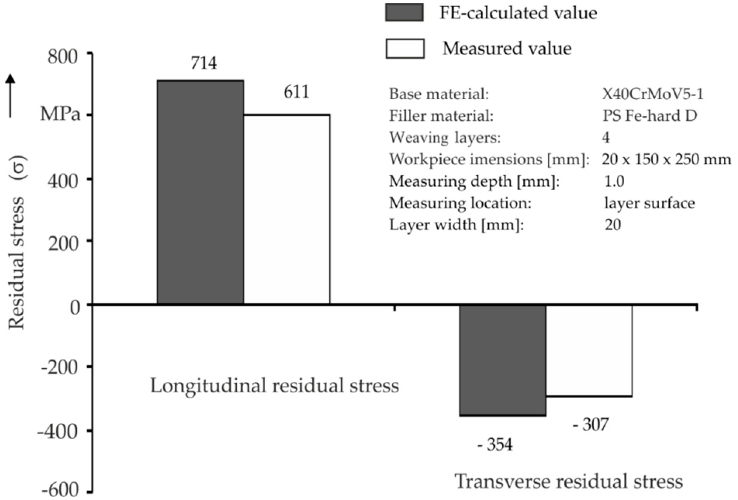
Figure 9. Comparison between calculated and measured stresses using the hole-drilling method.